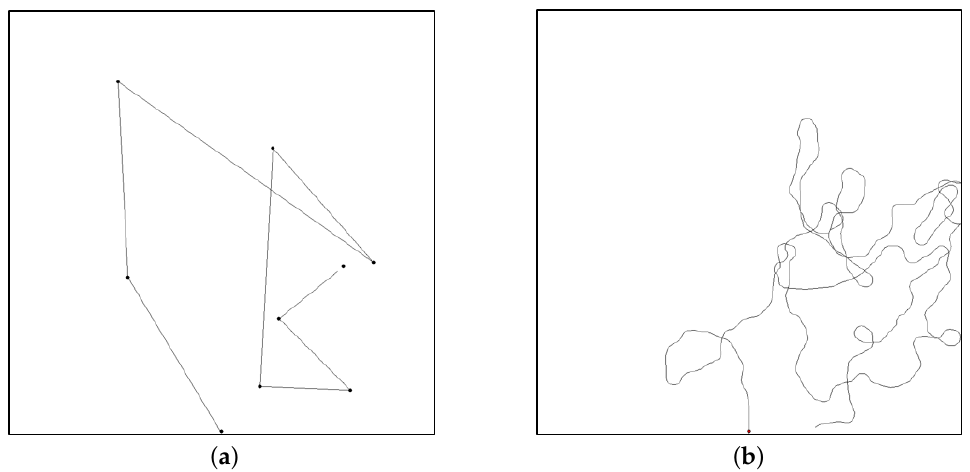
Figure 1. The examples of movement: ( a ) Random Waypoint model; and ( b ) Markov Process